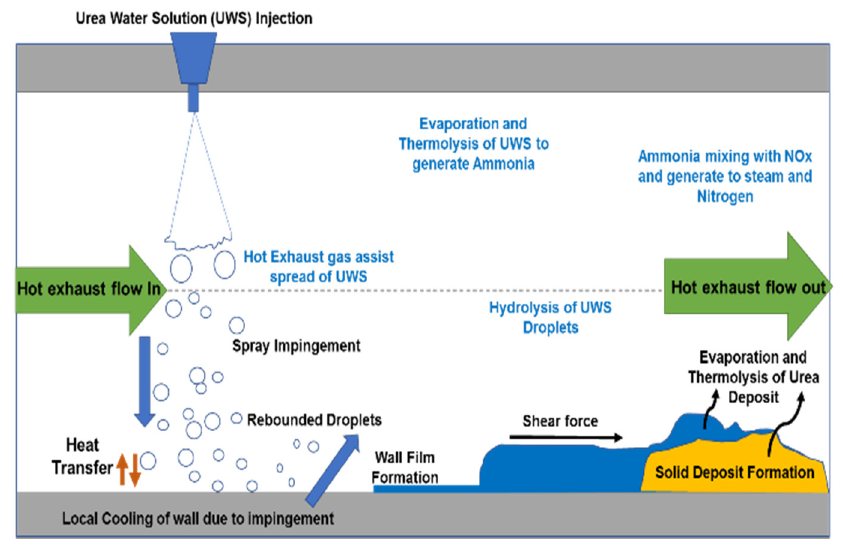
Figure 13. The urea injectors inside the SCR system: ( A ) L-type (original type) and ( B ) I-type (improved type).